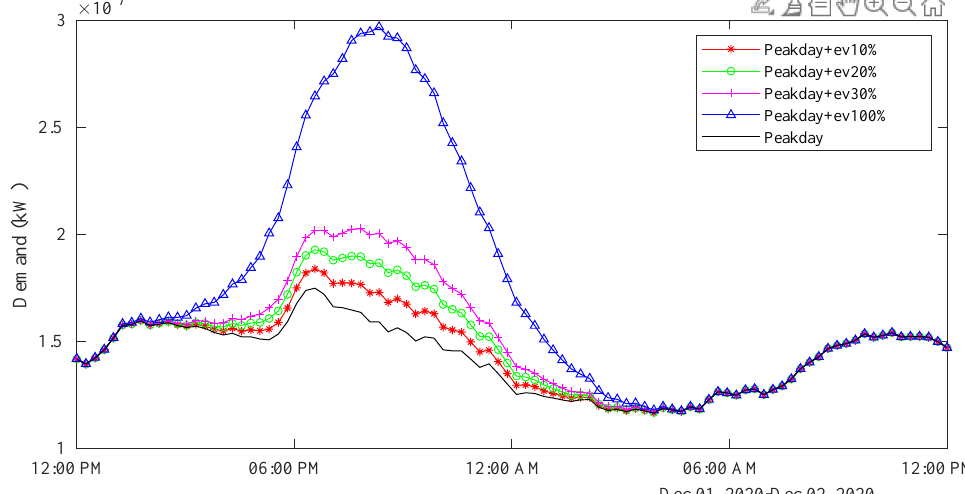
Figure 10. Load demand of the PEA when various levels of EV penetration are applied and normal distribution of S i is